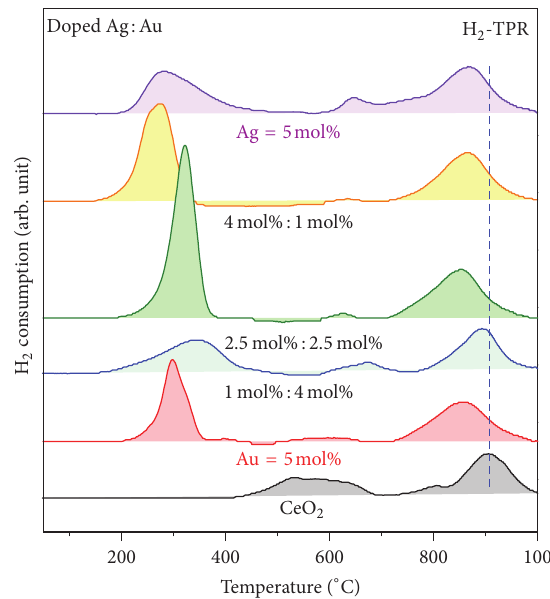
Figure 5: TPR profiles of undoped CeO 2 and Au and Ag doped and codoped (5/0, 0/5, 4/1, 2.5/2.5, and 1/4mol.%) CeO 2